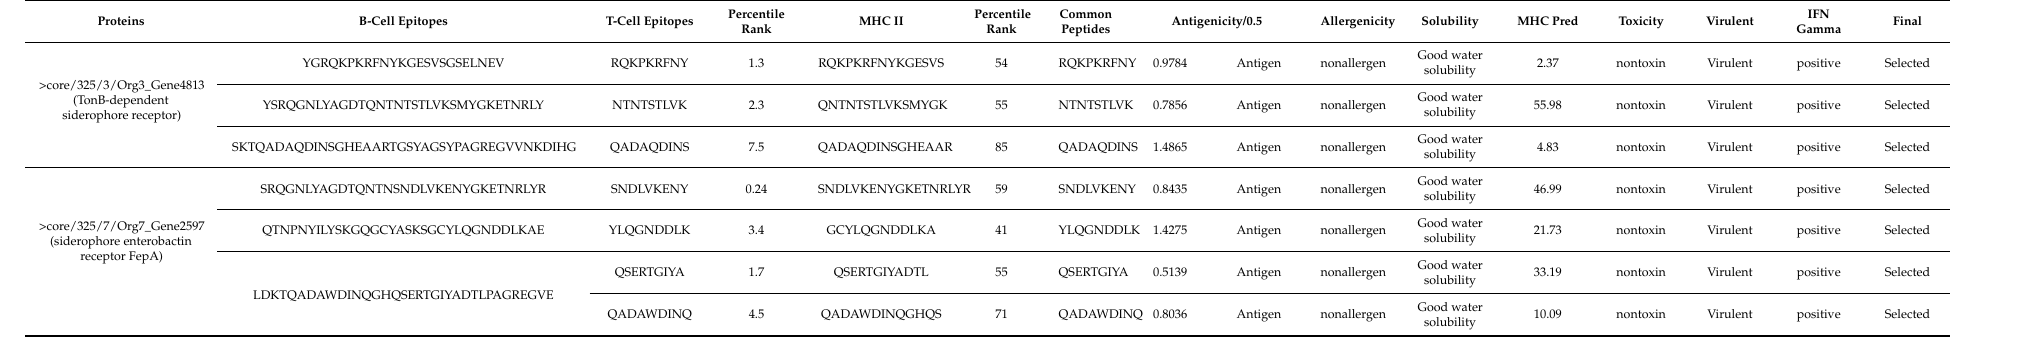
Table 2. Final set of selected epitopes that were filtered based on several